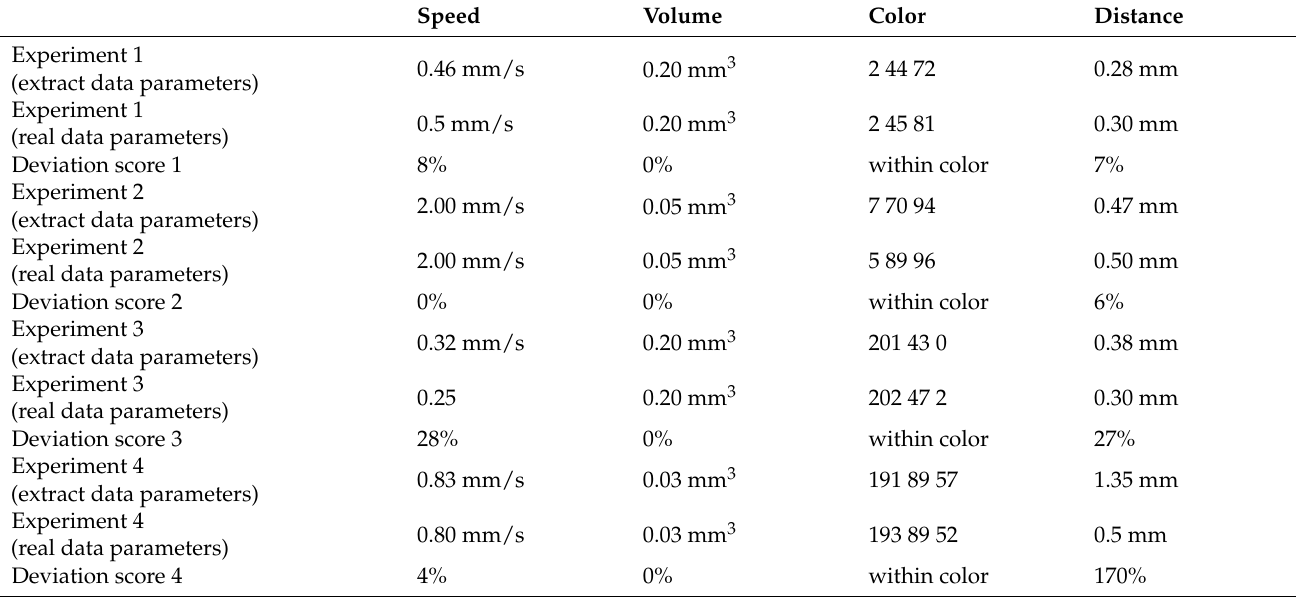
Table 3. The results